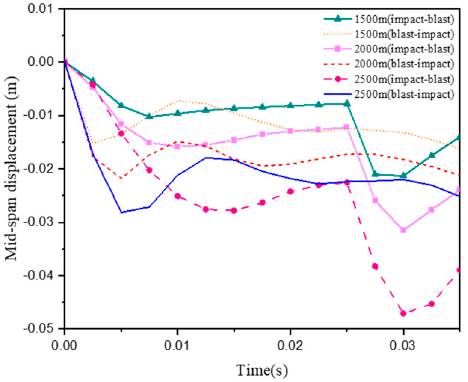
Figure 10. Time-history curves of mid-span displacement of beams under different beam spans.